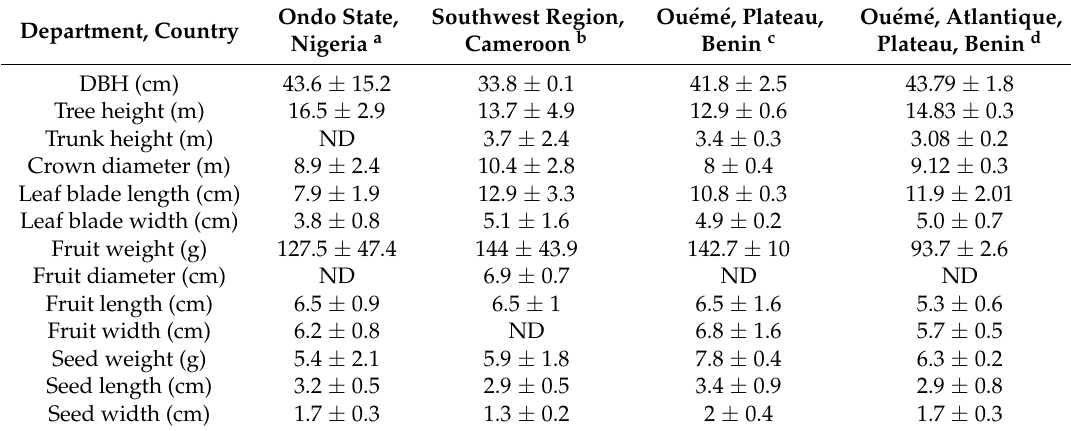
Table 1. Comparison of selected morphological features of G. kola from three different countries; values are provided as Mean ± SD.